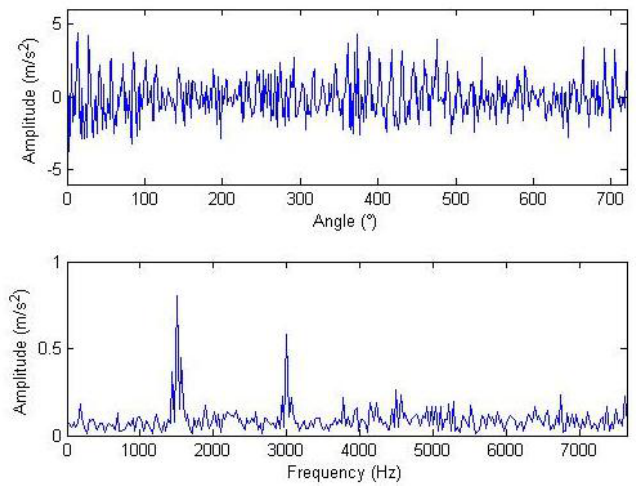
Figure 3. Signal waveform and frequency spectrum after